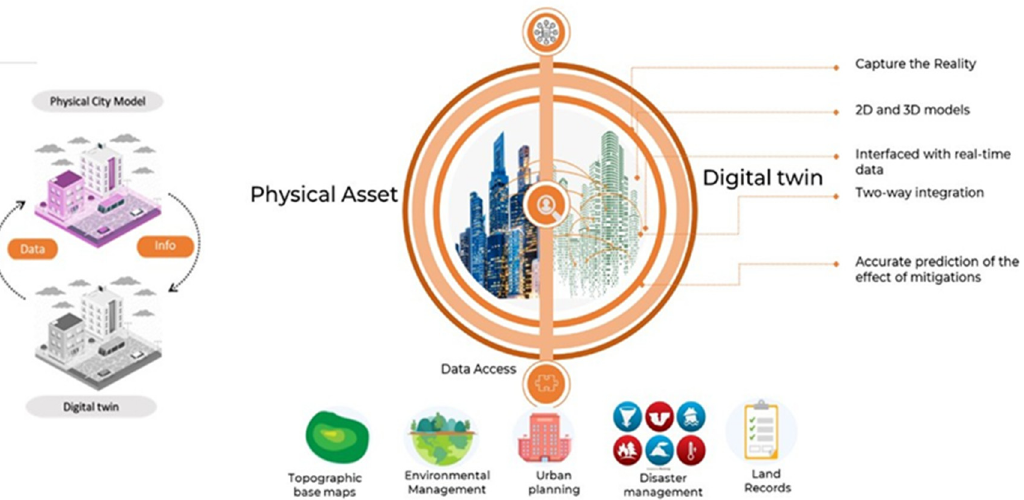
Figure 2. Sensor data allows physical city assets to be transferred to a digital twin model, allowing the city and its subsystems to be modified.